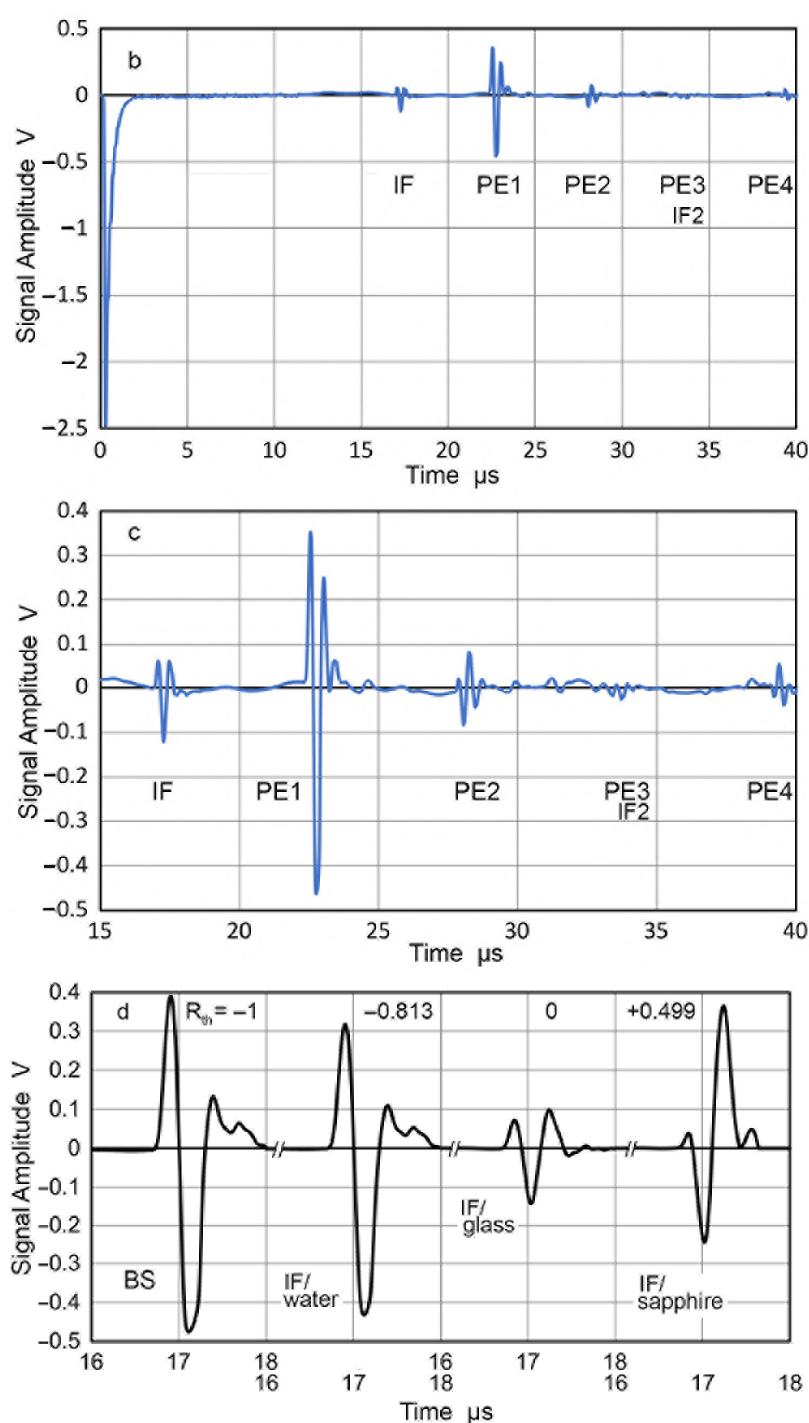
Figure 1. ( a ) Schematics of the pulse-echo experiment, using a pulser and a circuit for high-voltage pulse suppression from Beller et al. [48] with two stages of parallel diodes. ( b ) Signal waveforms for BK7 glass buffer (46.8 mm thick) and fused silica sample (16.0 mm thick). Initial 10 µ s is pulser output (attenuated 40 dB), followed by reflection from the buffer-sample interface (IF) and four pulse-echo signals (PE1 to PE4). The second IF (IF2) is barely visible after PE3. ( c ) IF to PE4 signals in an expanded scale. ( d ) Reflected waveforms from back surface (BS), interfaces with water (IF/water), BK7 glass (IF/glass) and sapphire (IF/sapphire). These show phase change as R th goes from − 1 to